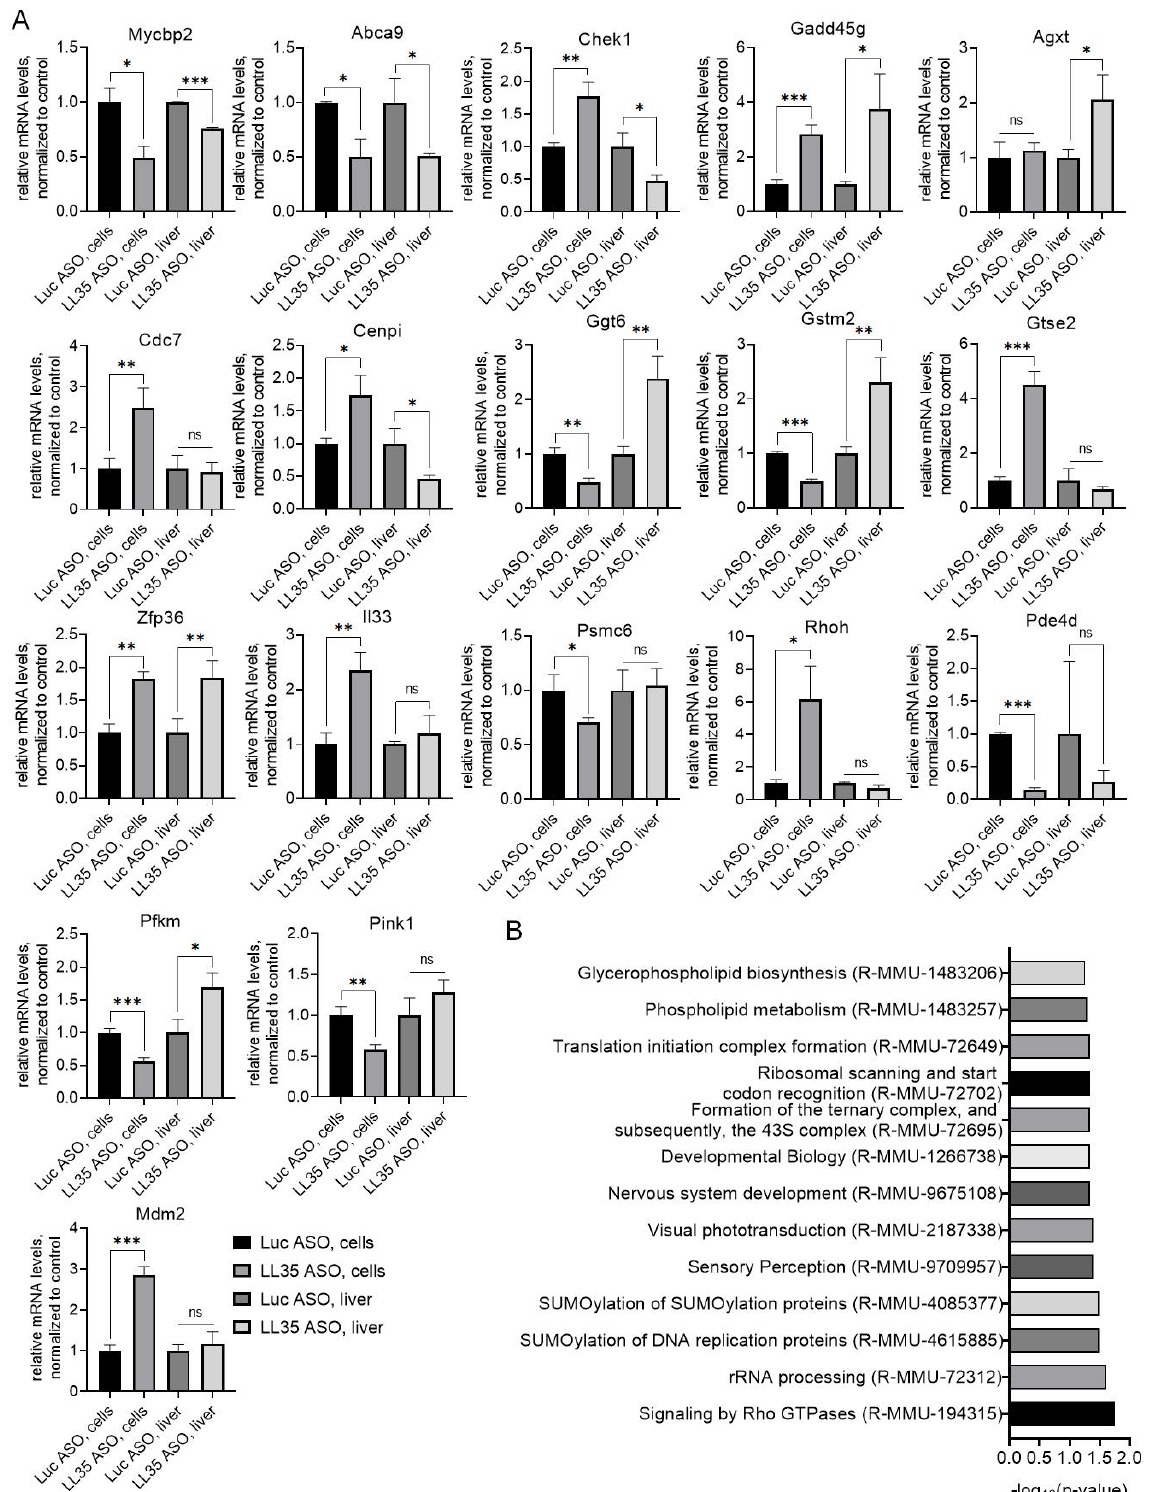
Figure 3. Transcriptome validation and proteome analysis of AML12 cells and murine liver after LL35 depletion. ( A ) Validation of transcriptome data by RT-qPCR, normalization on ACTB gene. ( B ) Top representative pathways obtained by PANTHER Reactome analysis for significantly changed proteins after LL35 depletion in AML12 cells. Results show mean ± SD. ns—not significant. * p < 0.05, ** p < 0.01 and *** p < 0.001.